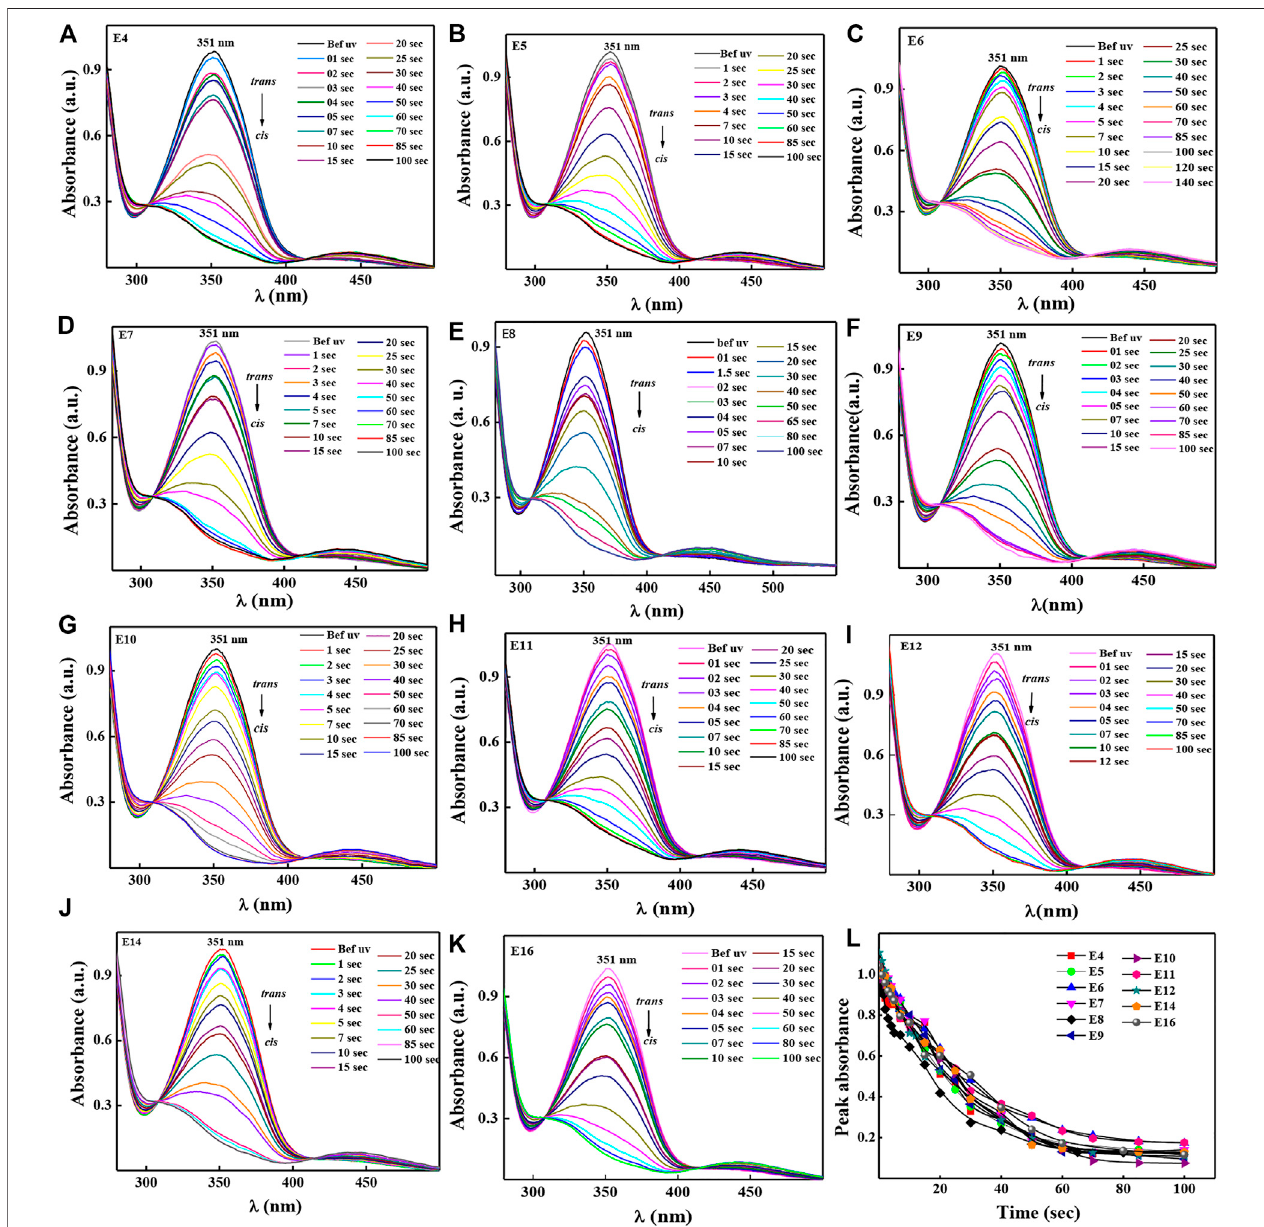
FIGURE 3 | Time dependent absorption spectra for the compound E4-E16 represented as Panel 3A – K by illuminating UV light of wavelength ∼ 365 nm and the intensity of ∼ 1 mW/cm 2 . Peak absorbance were calculated using the data obtained from a-k and plotted as a function of time in Panel 3L.